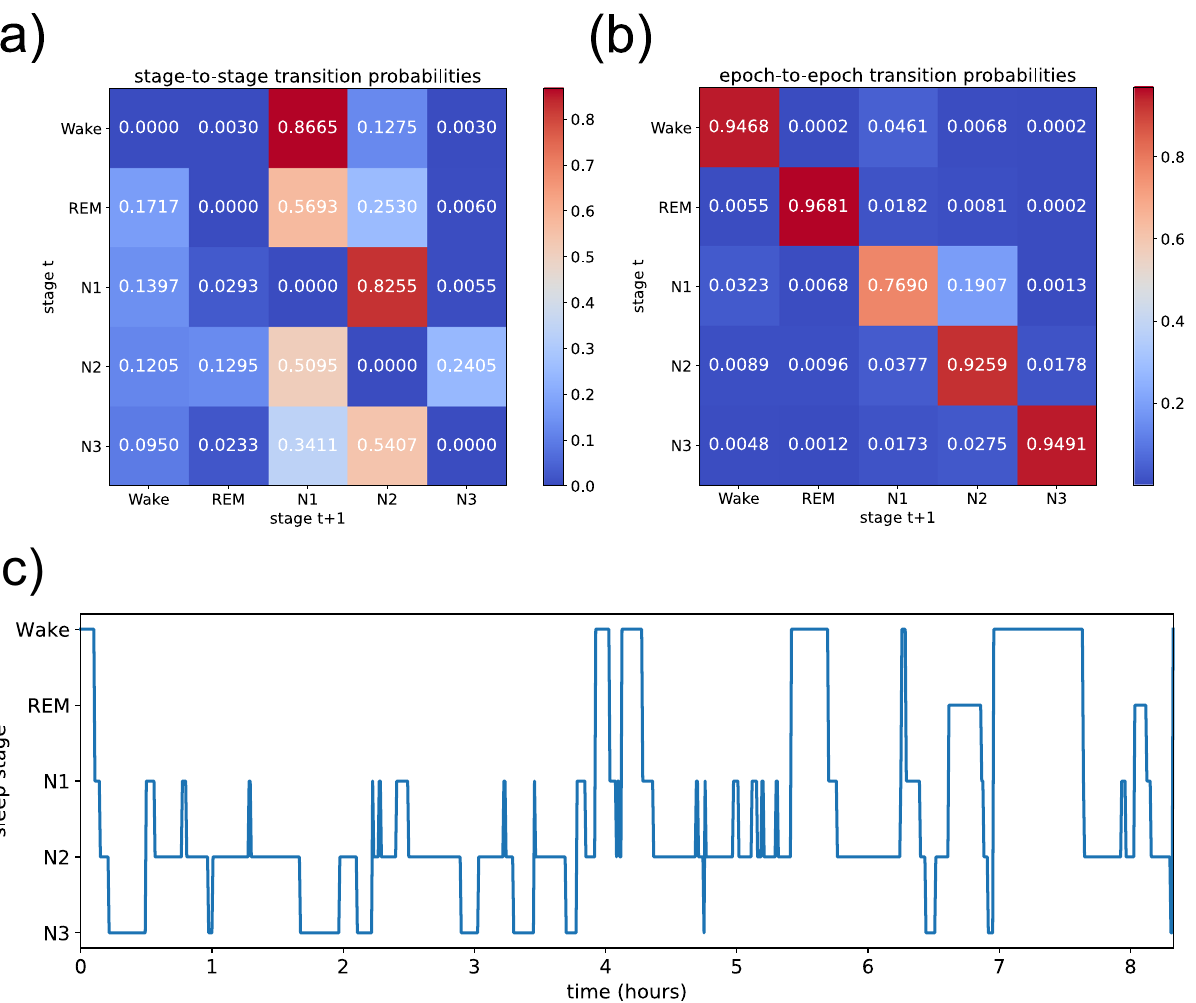
Fig. 5 Transition probabilities between sleep stages and the simulation of hypnograms. Transition probabilities (color coded) from one non-interrupted sleep stage to the next ( a ) and from one 30s epoch to the next ( b ). The stage-to-stage probabilities describe a strong propensity for transitions from Wake to N1 and from there to N2. After this, the most likely behavior is an oscillation between N1 and N2, or between N2 and N3. c Example of a simulated hypnogram, where the random walk between sleep stages is modeled as a Markov process, based on the epoch-to-epoch transition probabilities (top